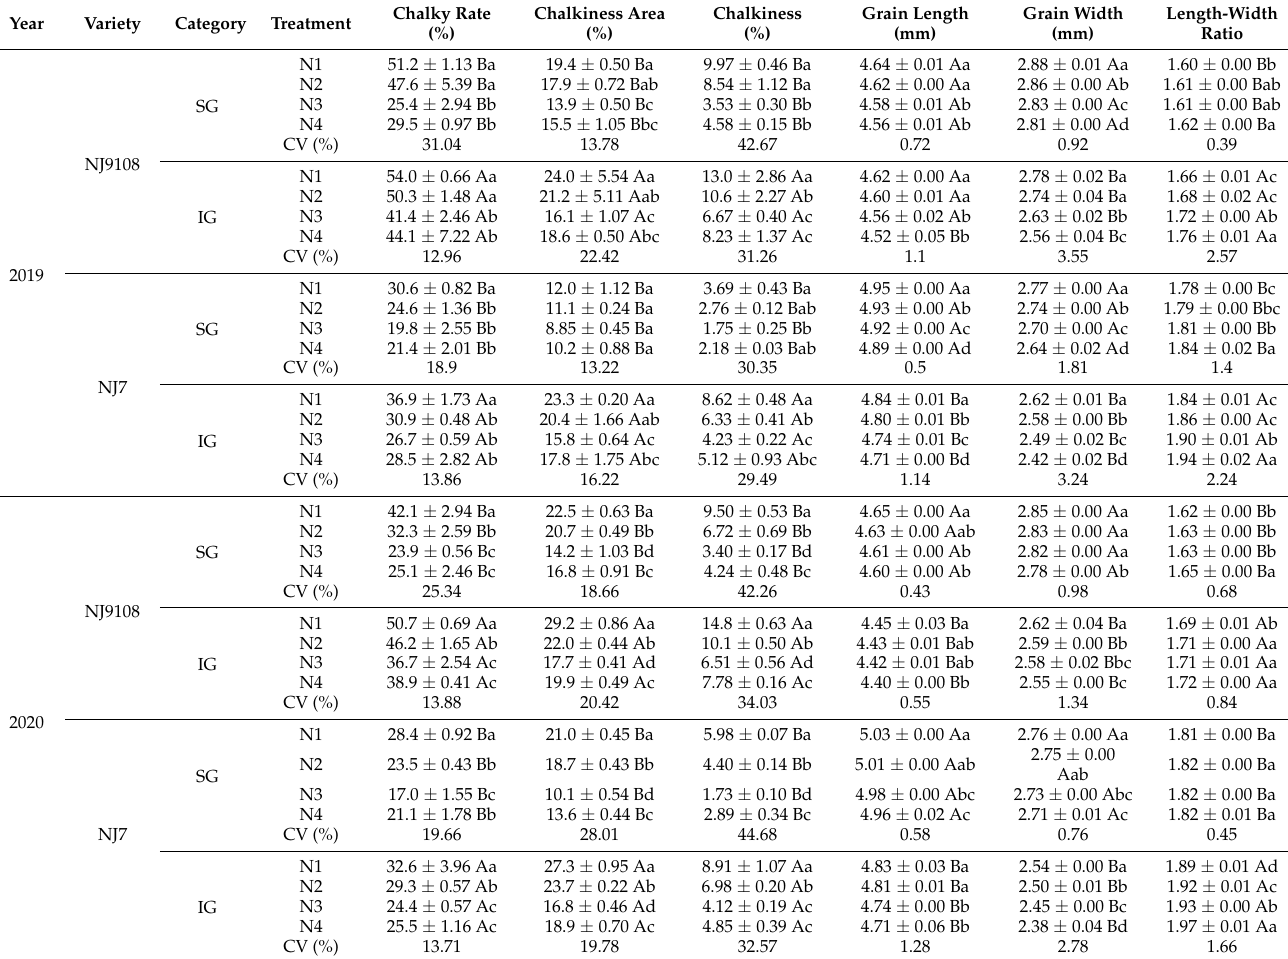
Table 3. Effects of nitrogen fertilizer levels on appearance quality of strong and weak grains in rice in 2019 and